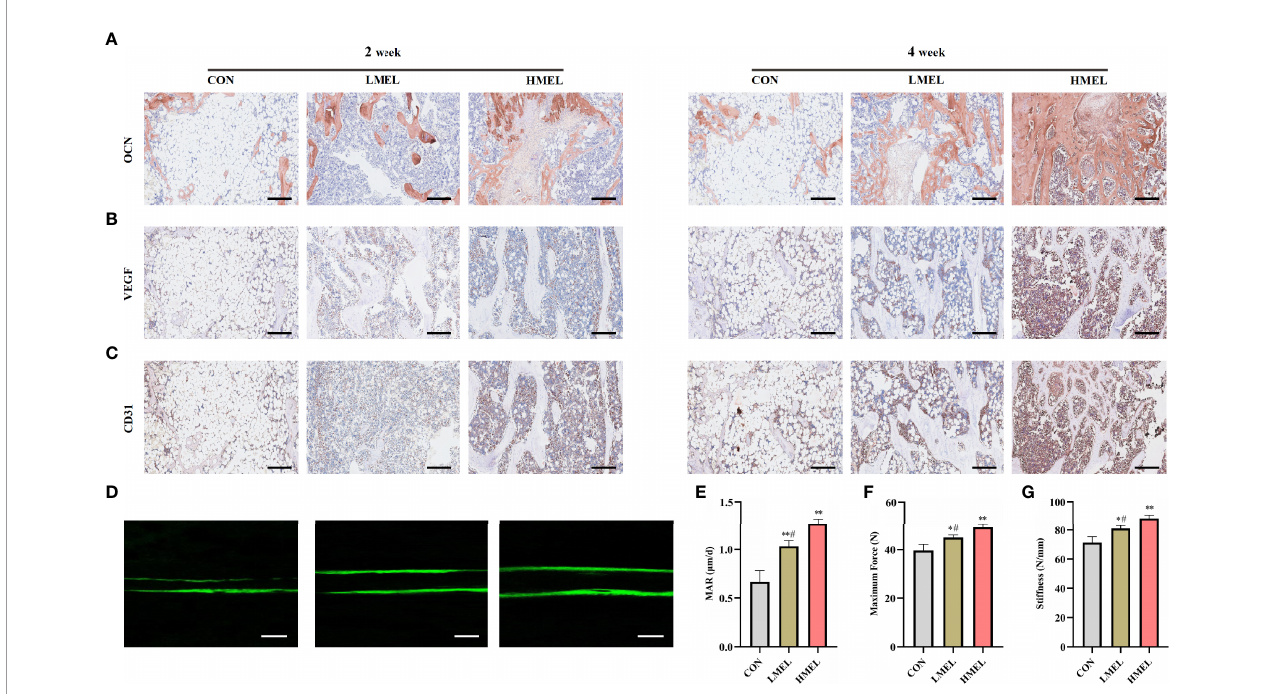
FIGURE 6 | Melatonin accelerated bone repair by promoting the osteogenesis and angiogenesis of tibia defect in ovariectomized rats. (A) Images of immunohistochemical staining of osteocalcin in the tibia defect (scale bars, 200 m m). (B) Images of immunohistochemical staining of vascular endothelial growth factor in the tibia defect (scale bars, 200 m m). (C) Images of immunohistochemical staining of CD31 in the tibia defect (scale bars, 200 m m). (D) New bone formation was detected by sequential fl uorescent labeling of calcein (scale bars, 10 m m). (E) Quantitative analysis of mineral apposition rate. (F) Maximum force determined experimentally by three-point bending test. (G) Stiffness determined experimentally by three-point bending test. The data are presented as means ± SEM. * p < 0.05, ** p < 0.01 vs . control group, # p < 0.05 vs . high-dose melatonin treatment